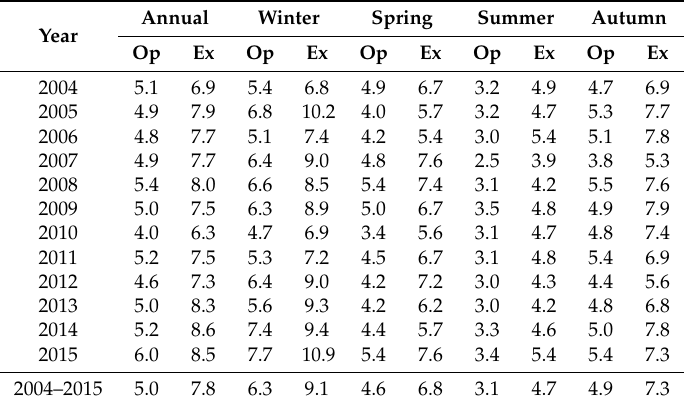
Table A4. Annual and seasonal Op and Ext H s thresholds (m) at BB.